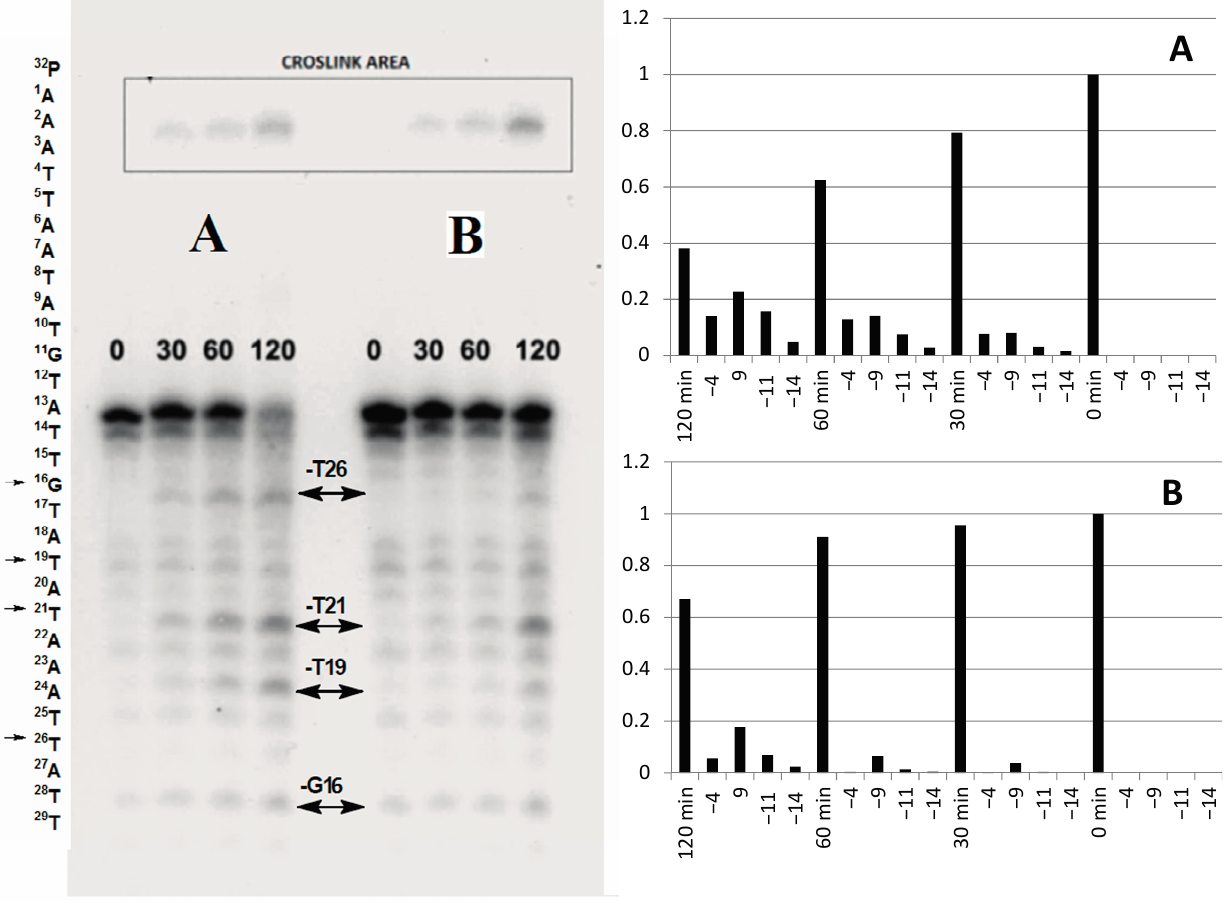
Figure 2. Autoradiogram of the results of irradiation of AQ-linked oligo -A ( A ) and oligo- B ( B ) and standard cleavage ratios of the investigated double-stranded oligonucleotides. Irradiation time 0, 30, 60, 120 min, -4 corresponding to T26, -9 to T21, -11 to T19, -14 to G19 in the sequence of 32 P radiolabelled